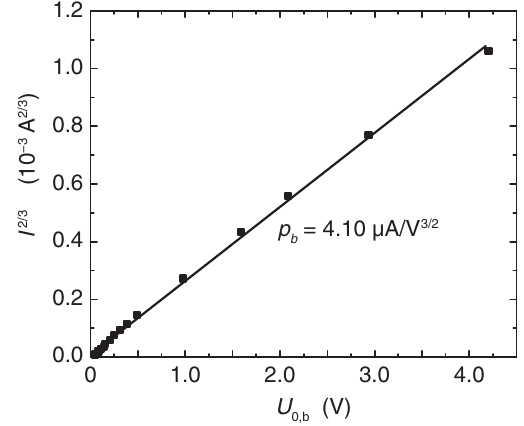
FIG. 6. Perveance law between the minimum effective accel- erating potential realized, U 0 Dots connected by the full line: result of the breaking voltage measurements. The given maximum experimental perveance p is determined from the fitted straight